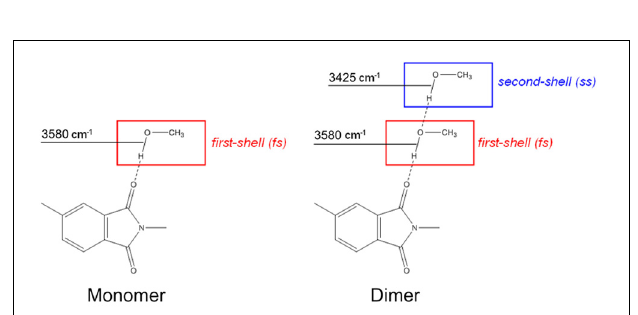
sample). The color code is as follows: black trace: p / p 0 = 0 (dry sample); red trace: p / p 0 = 0 . 2; blue trace: p / p 0 = 0 . 3; green trace: p / p 0 = 0 . 4; cyan trace: p / p 0 = 0 . 5; brown trace: p / p 0 = 0 . 6.